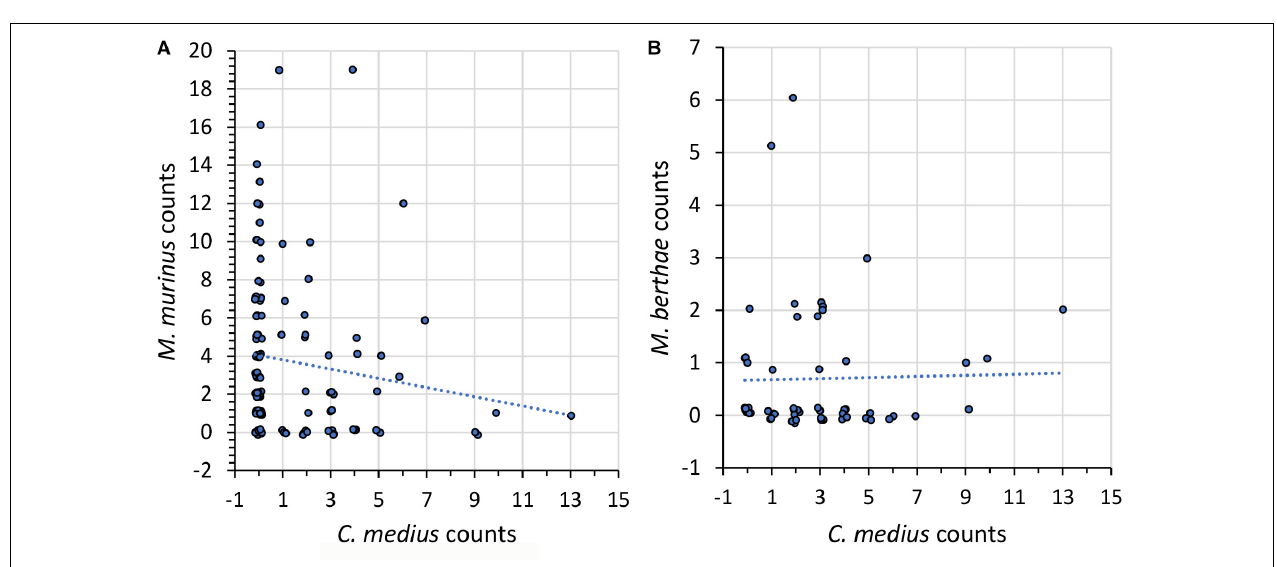
FIGURE 2 | As in Figure 1 but for numbers of sighted (A) M. murinus and (B) M. berthae as a function of the number of M. coquereli individuals.